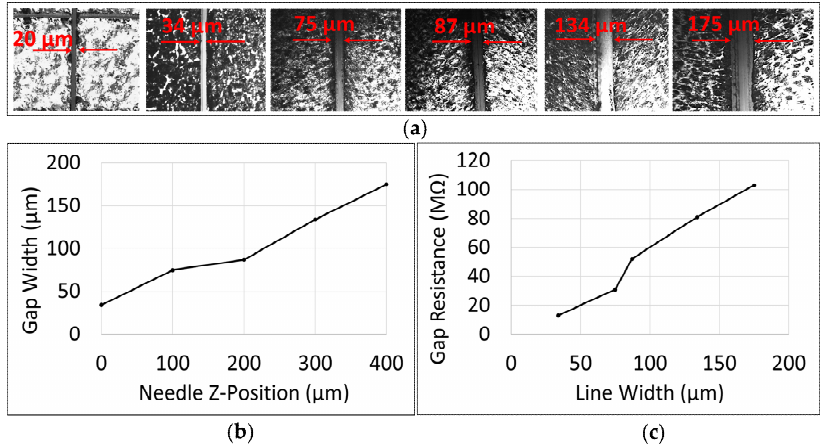
Figure 12. Characterization of scraped LM. ( a ) Images of the scraped LM with different gap widths. ( b ) Gap width in the sprayed LM vs. the z -position of the needle. ( c ) Resistance measured across the gap vs. gap width.